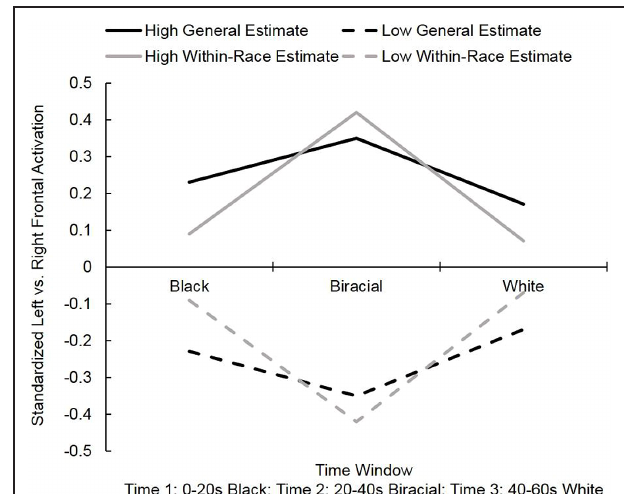
FIGURE 2 | Mean standardized left vs. right frontal activation observed while participants viewed 60-s videos of faces morphing from Black to White [( y > 0 = greater relative left activation (approach); y < 0 = greater relative right activation (withdrawal)] in Study 1. “High” and “low” values represent the frontal asymmetry values of participants at 1 SD above and below the mean on the general and within-race genetic overlap